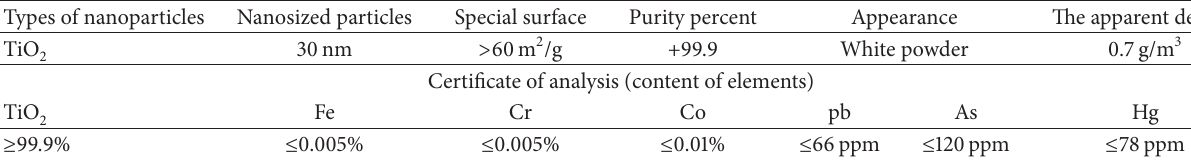
Table 1: Physical properties of the nanoparticles.